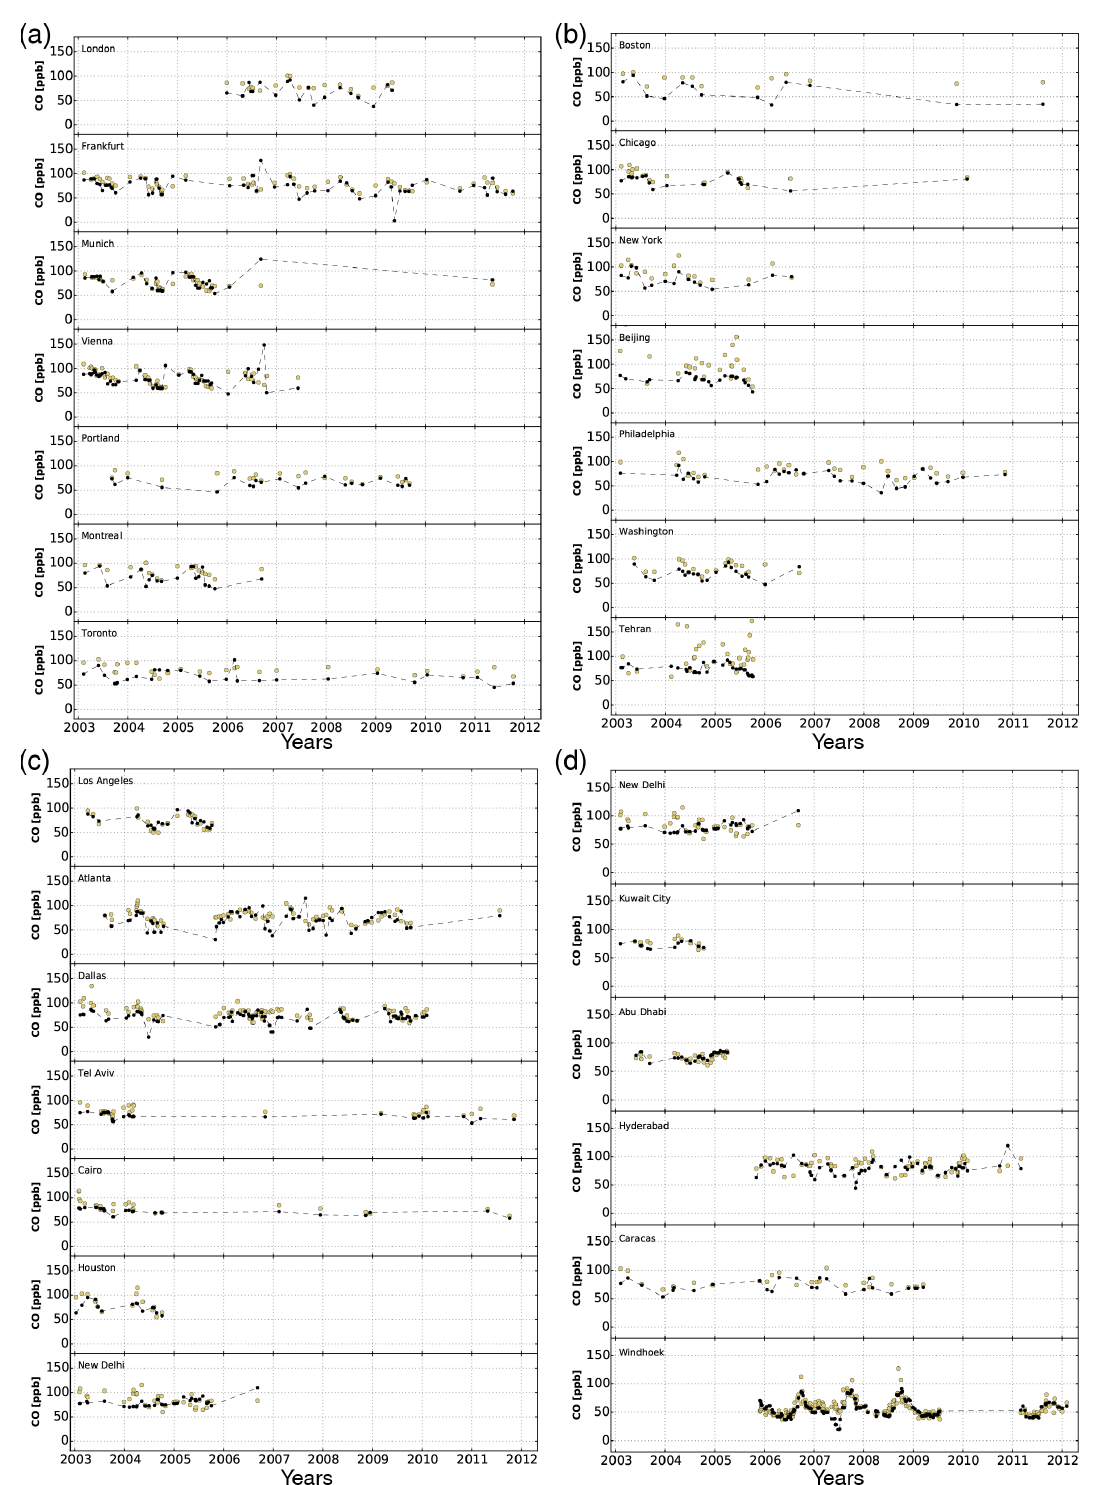
Figure A1. As Fig. 6, but for MOZAIC/IAGOS measurements indicated in